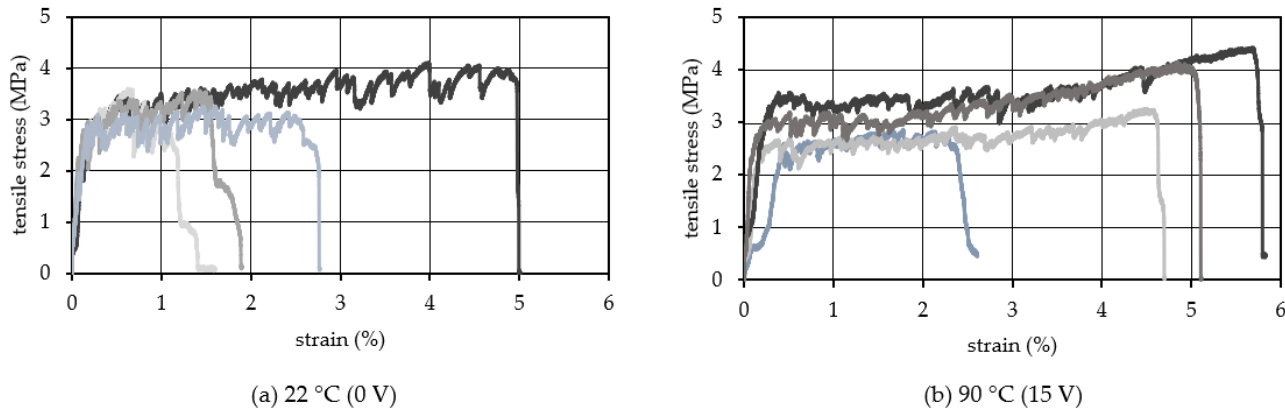
Figure 6. Tensile stress − strain relationship (Vf: 1.50 vol.%).